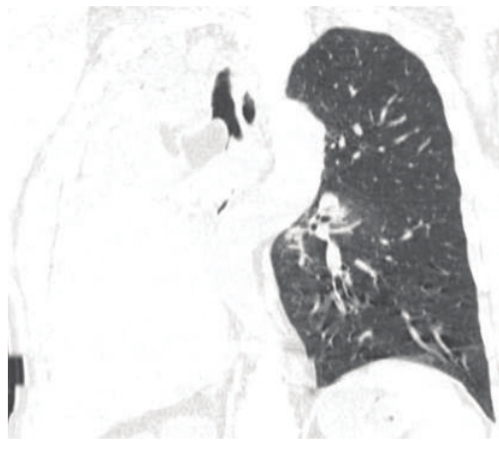
Figure 2: Reformatted reconstruction showed adipose mass oc- cluding the right main bronchus and right lung atelectasis.